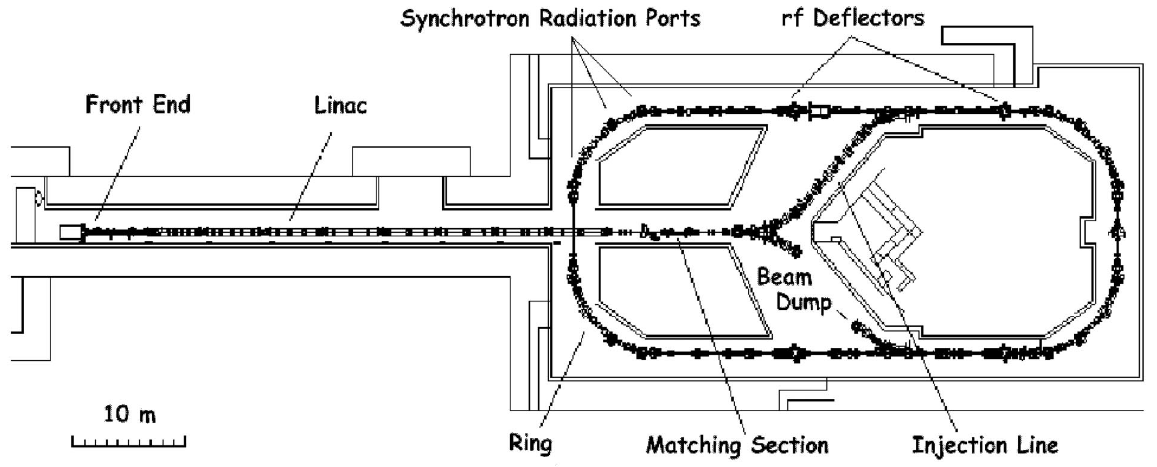
FIG. 1. General layout of the CTF3 Preliminary